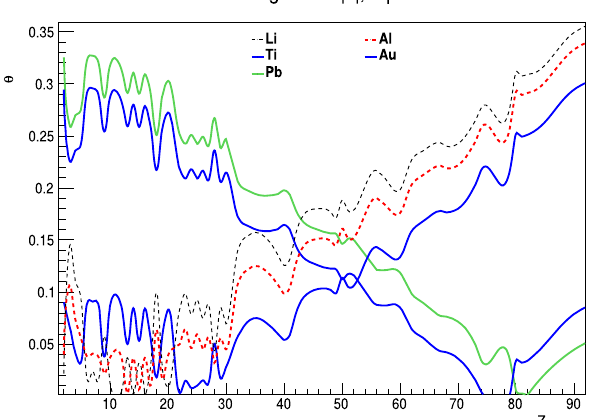
Fig. 6 The misalignement angle θ (defined in Eq. (A.12) between nucleon target vectors. The decreasing lines are lead (green, upper) and Au (blue); the rising lines are titanium (blue) and Al (red, dashed, middle) and lithium (black, dashed, upper)